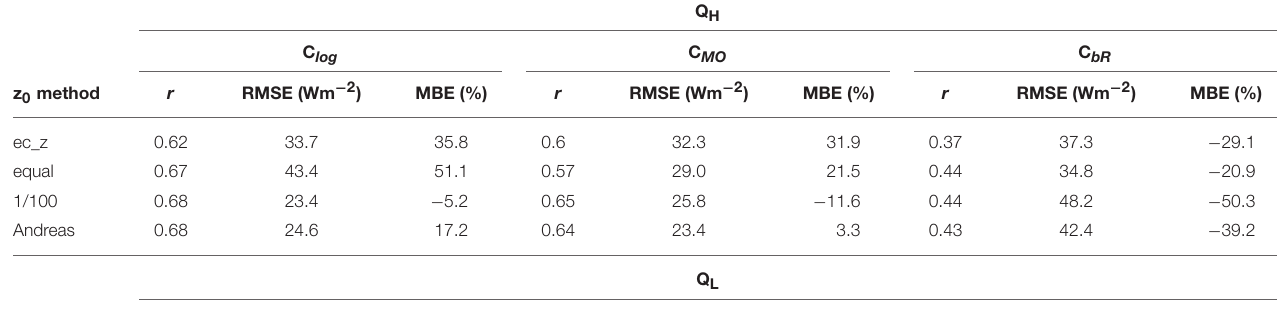
TABLE 3 | Performance of the tested bulk methods in modeling the EC-observed turbulent fluxes of sensible and latent heat.